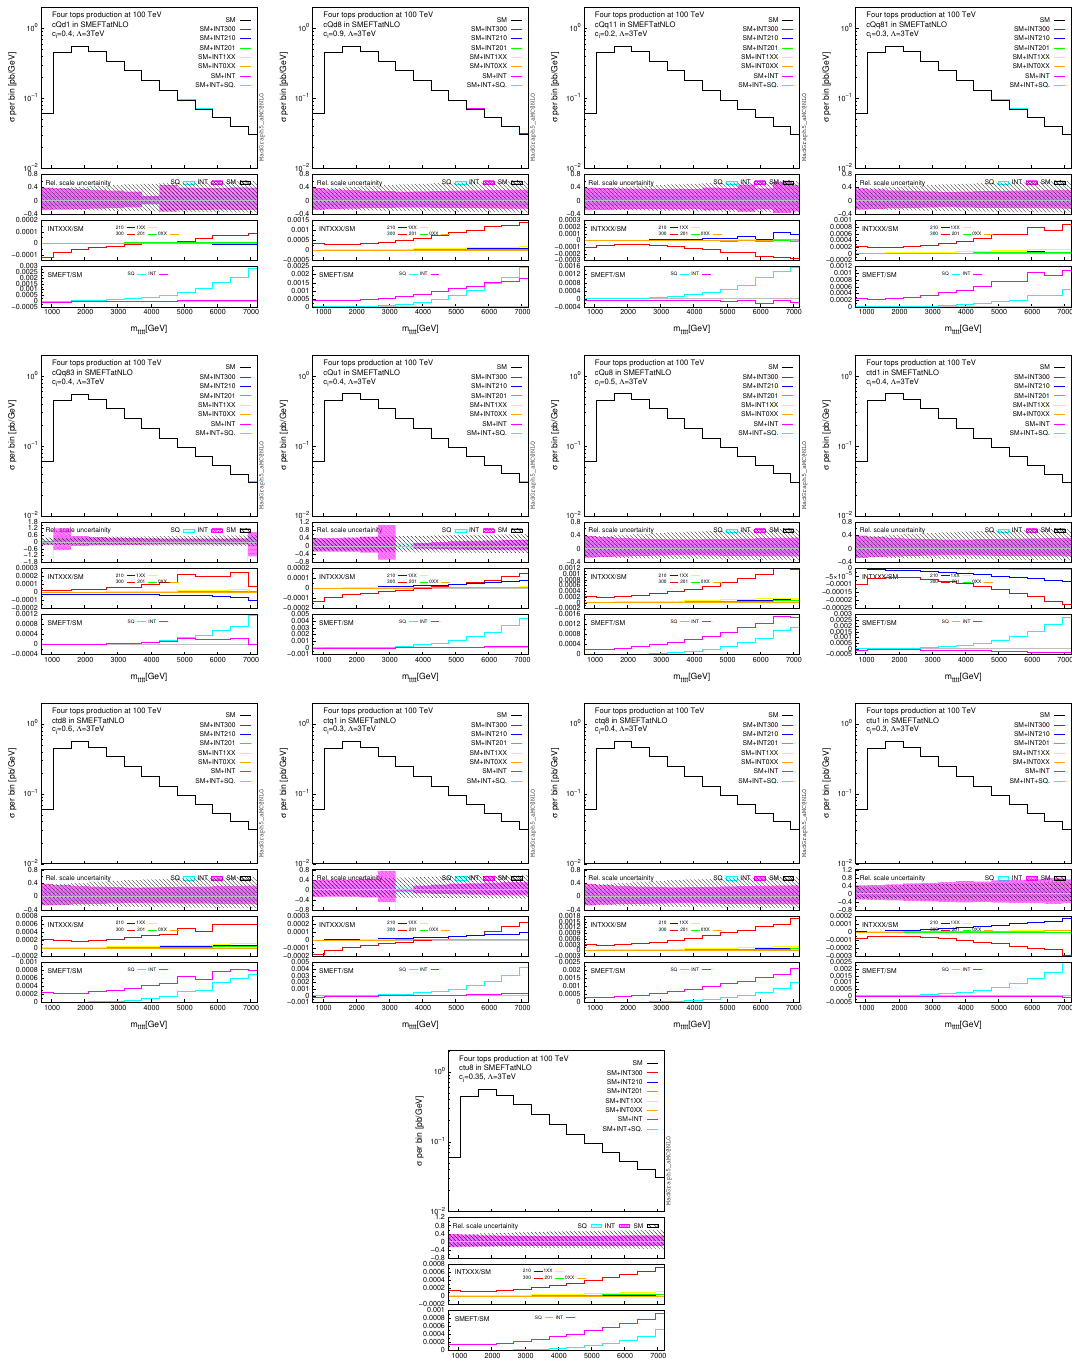
Figure 23 . Same as figure 13 but for the rest of the four-fermion